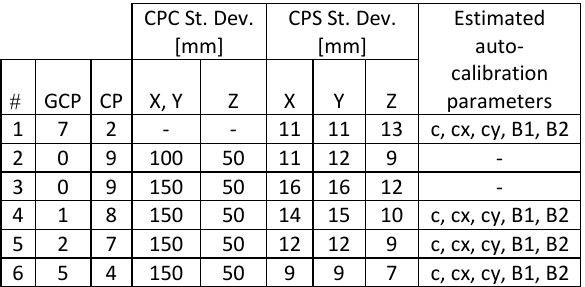
Table 1. Results in terms of Check Points (CP) accuracies for a series of simulations performed on a test block of 170 images.